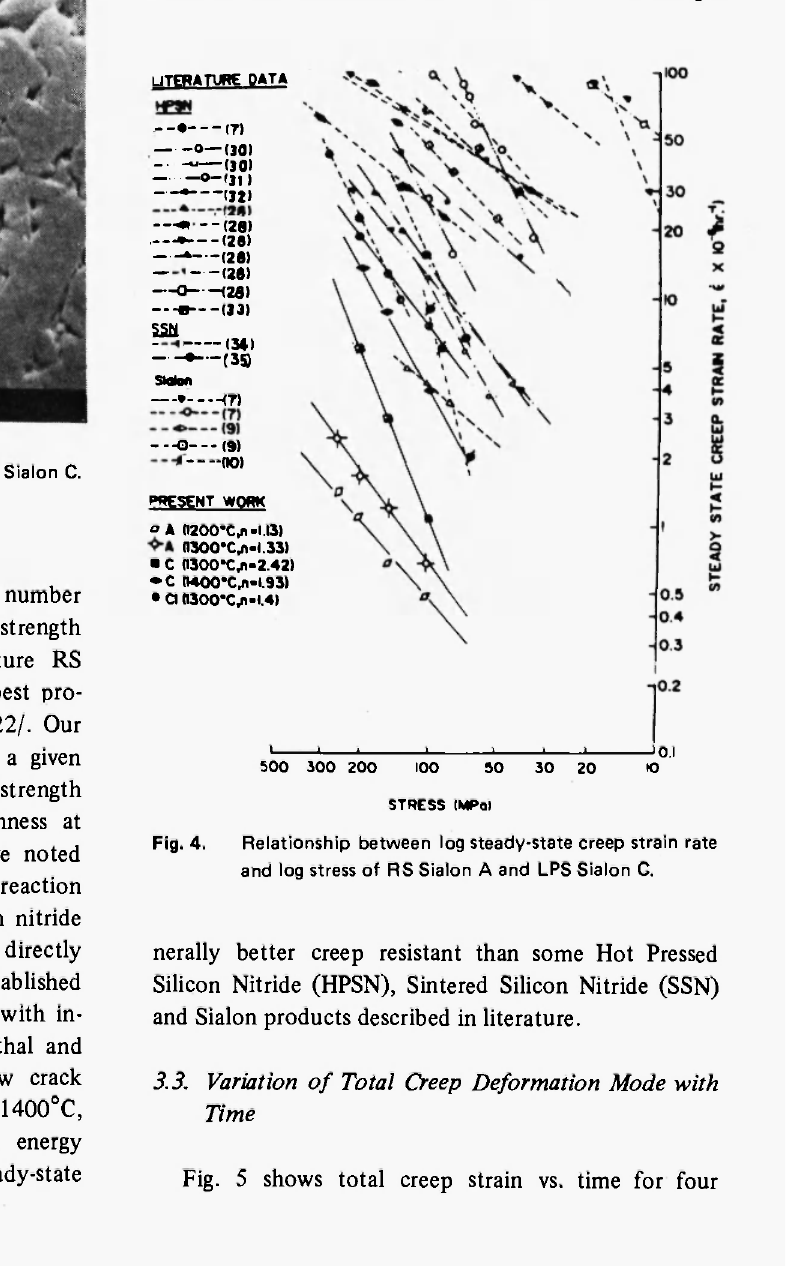
Relationship between log steady-state creep strain rate and log stress of RS Sialon A and LPS Sialon